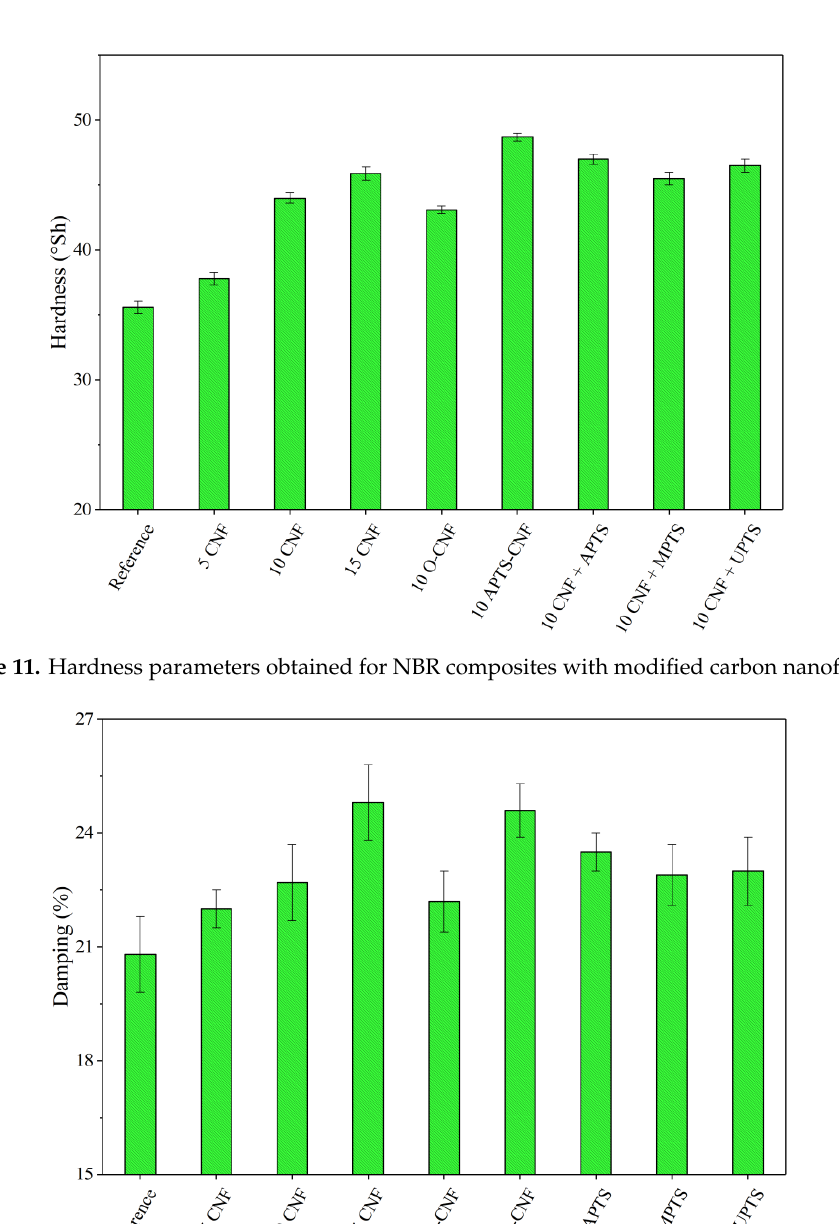
Figure 10. Tensile strength test results obtained for NBR composites with modified carbon nanofibers.